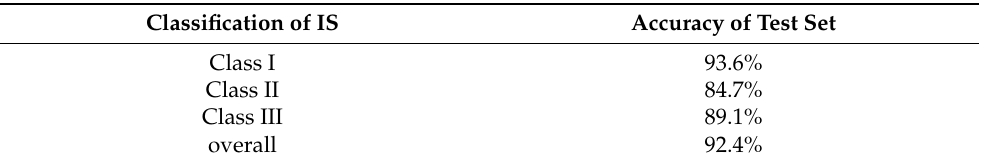
Table 3. The classification accuracy of test set.